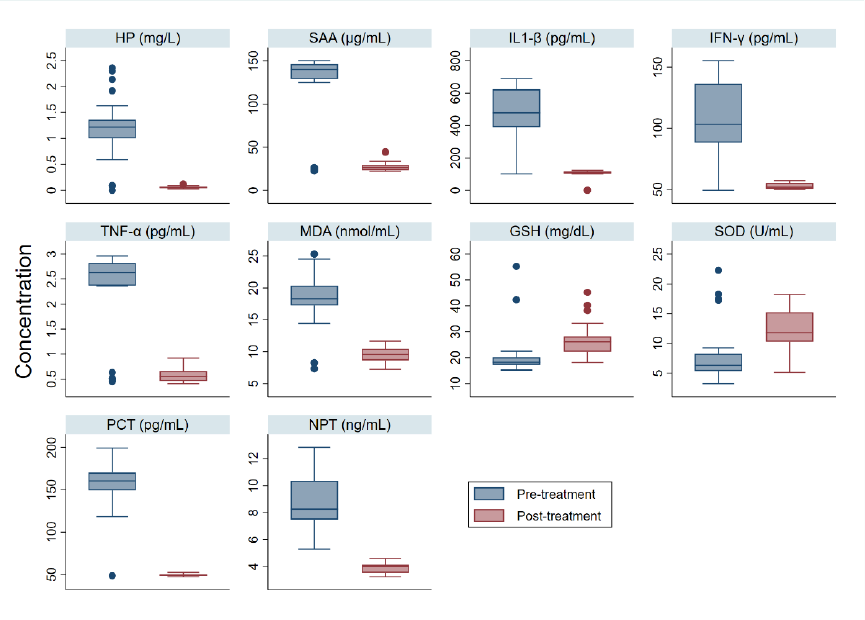
Figure 4. Box plots displaying variability of acute-phase proteins (HP, Haptoglobin; SAA, serum amyloid A), proinflammatory cytokines (IL1- β, Interleukin one beta; IFN- γ, Interferon gamma; TNF- α, tumor necrosis factor alpha), oxidative stress markers (MDA, malondialdehyde; GSH, reduced glutathione; SOD, super oxide dismutase), procalcitonin (PCT), and neopterin (NPT) in the serum of diarrheic calves naturally infected with C. parvum ( n = 55) pre- and 7 days post-treatment. A difference with p < 0.05 was considered significant.